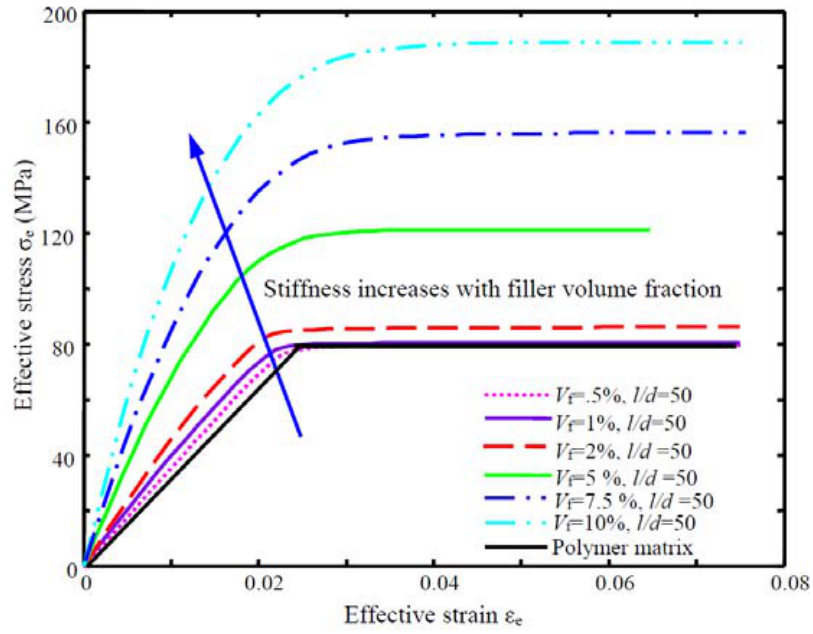
Figure 11. Effective stress-strain diagram σ e - ε e of the PNCs with the clay-particle aspect ratio ρ = 50 (plane-strain, case I).